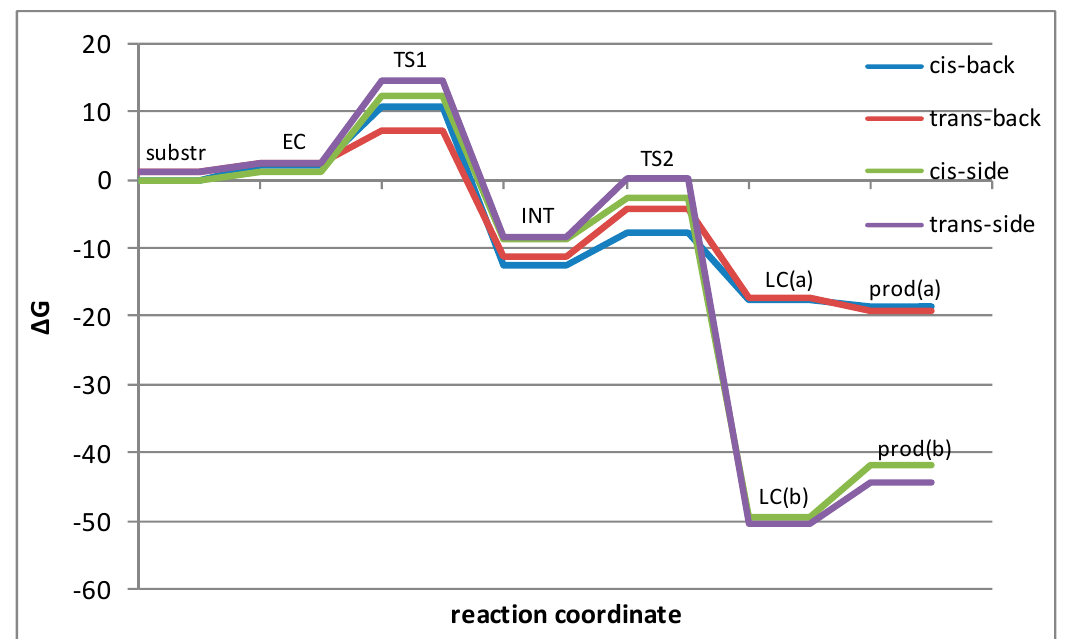
Figure 9. Free energy profiles for the substitution of fluorine by OH − in cis and trans diastereomers of 6(F) ; attack from the back to the fluorine (back) and from the back to oxygen in the ring (side); EC-complex of substrates (early complex), TS1-1st transition state (approach of OH − ), INT-P V intermediate, TS2-2nd transition state (departure of F − ), LC-complex of products (late complex) according to route ( a ) or ( b ) and ( c ) (Scheme 21), respectively (Tables 5 and 6). Route ( a ): >P(S)F + OH ( − ) → >P(S)OH + F ( − ) , Δ G = − 18.6 ( cis ); − 19.2 kcal/mol ( trans ). Route ( b ) and ( c ): >P(S)F + OH ( − ) → >P(S)O ( − ) + HF , Δ G = − 41.8 ( cis ); − 44.4 kcal/mol ( trans ).